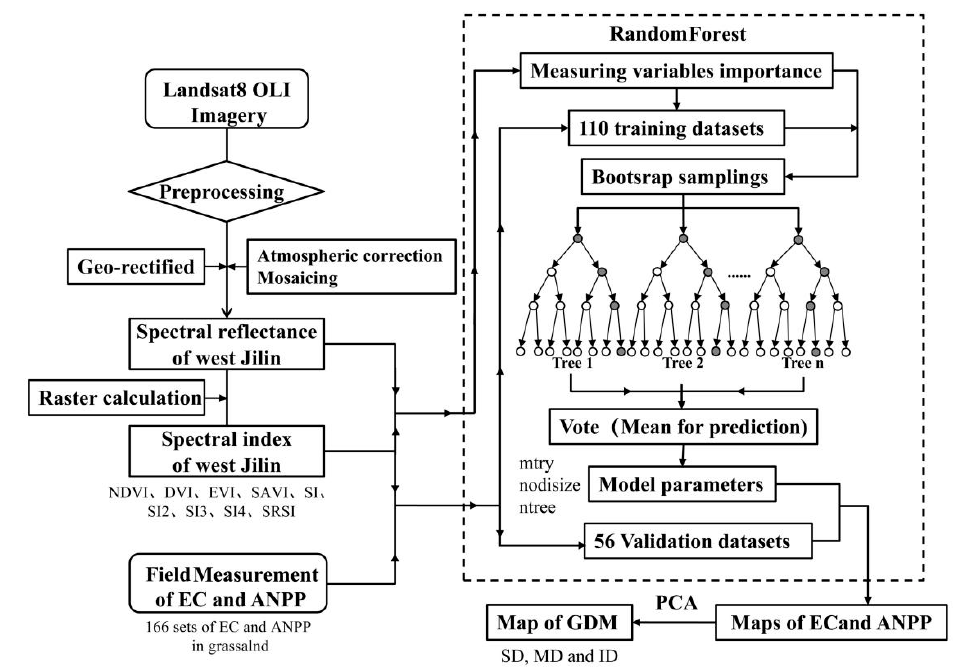
Figure 3. The flow-process diagram of random forest (RF) to assess grassland degradation parameters using remote sensing images and field measurements in Semiarid West Jilin, China (SD is slightly degraded, MD is moderately degraded, and ID is intensively degraded).